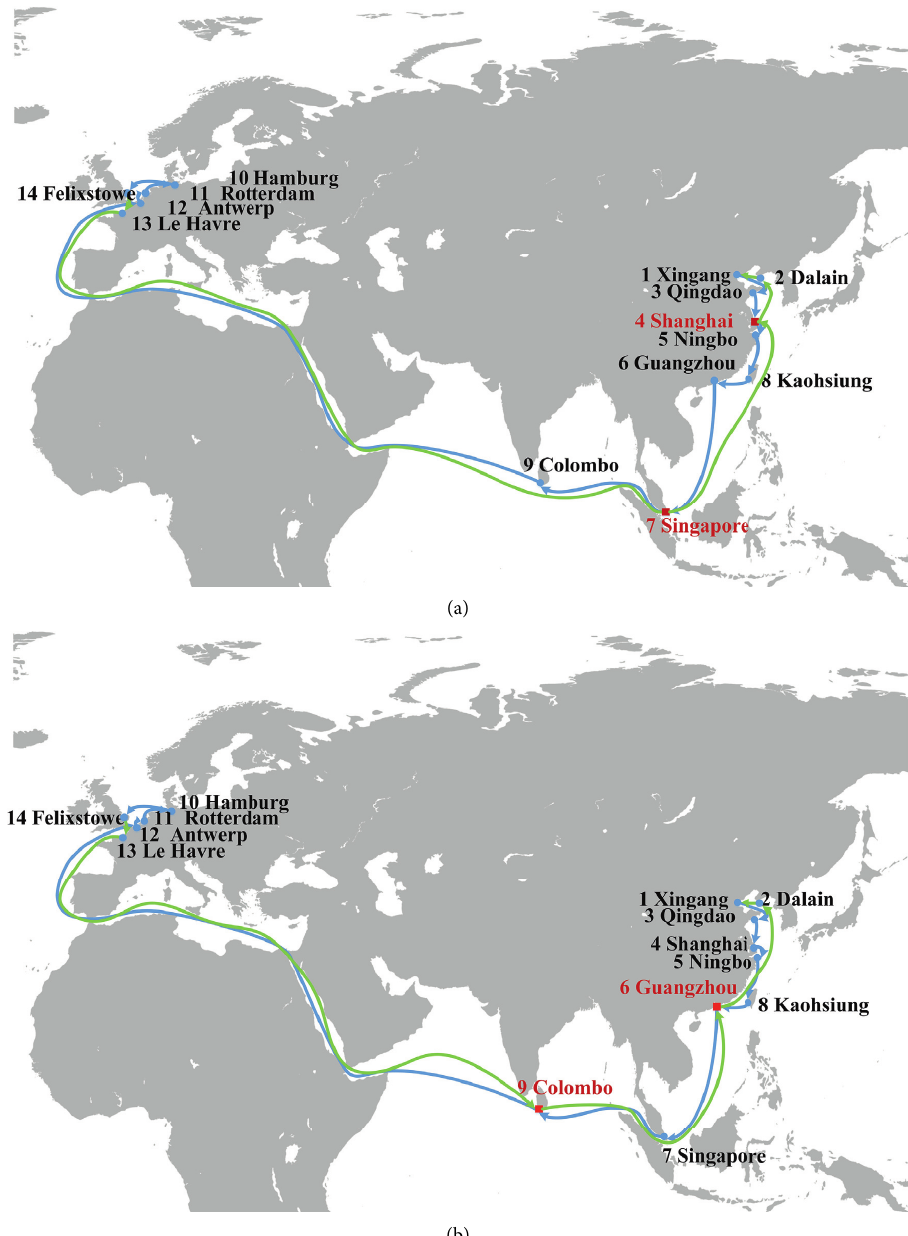
Figure 5: The results of LSNs ( G 1 and G 2 ) in NA phase at { W � 155, Ω �